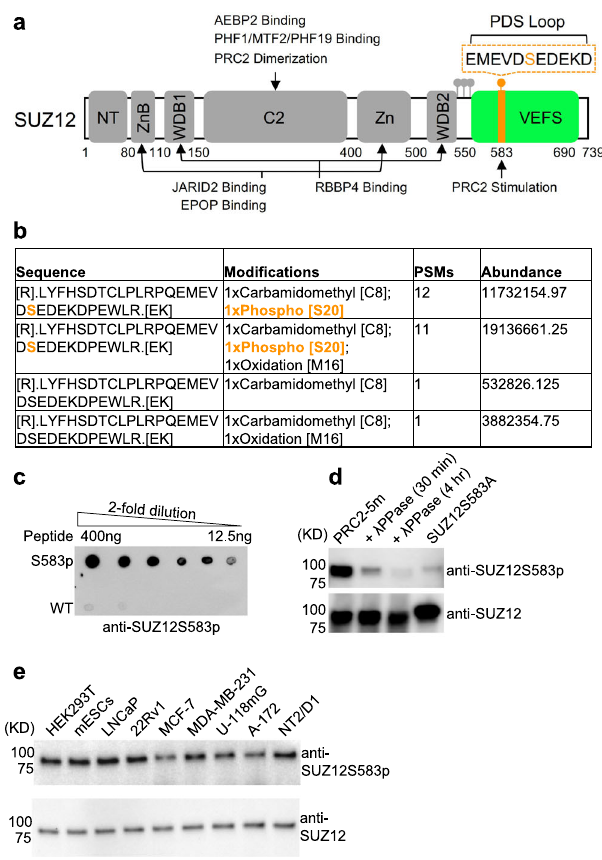
Fig. 1 | Residue S583 of human SUZ12 is phosphorylated. a Domain structure of SUZ12. Structurally characterized SUZ12 domains are represented by gray blocks exceptthatthe VEFS domainincluded in thecurrent studyis colored ingreen. The PDS loop harboring S583 is highlighted in orange with the amino acid sequence shown above. b Peptides identi fi ed for SUZ12 by LC-MS/MS which contain S583. Peptide sequence, modi fi cations, number of peptide spectrum matches (PSMs), and peptide abundance are listed. The phosphorylated residue that was unam- biguously assigned is shown in orange. The percentage of phosphorylation was calculated based on a comparison of the abundances of the phosphorylated and unphosphorylated peptides. c Dot blot. Apo and phosphorylated peptides were applied on a nitrocellulose membrane with a serial dilution. Phospho-speci fi c reactivity of the developed anti-SUZ12S583p antibody was analyzed. A repre- sentative of three independent experiments is shown. d Effect of λ phosphatase treatment and serine mutation on ectopically expressed PRC2-5m, EZH2 – EED – SUZ12 – RBBP4 – AEBP2. The total amount of PRC2-5m is indicated by anti-SUZ12 signals. S583 phosphorylation level is indicated by signals of the anti- SUZ12S583pantibodydeveloped inthisstudy (uncropped gelimages of this fi gure are shown in Supplementary Fig. 16). A representative of three independent experiments is shown. e Levels of S583 phosphorylation in stem cells and cancer cells. Anti-SUZ12S583p signals were generated using immunoprecipitates of anti- SUZ12 antibody to avoid a non-relevant contaminating band (also see Supple- mentary Fig. 2). A representative of three independent experiments is shown. Source data are provided as a Source Data fi